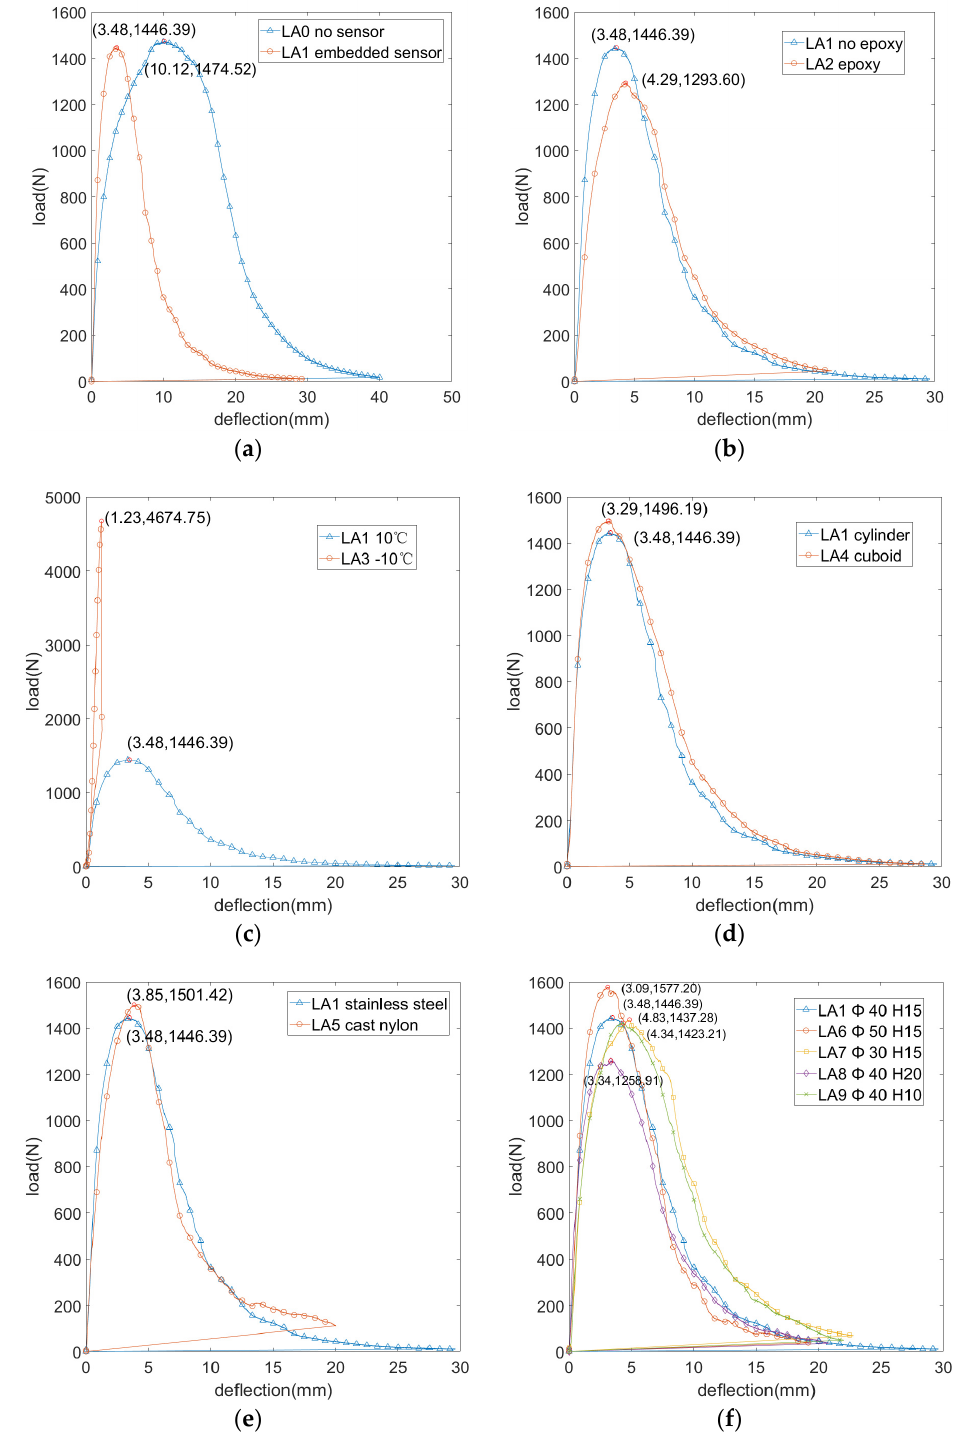
Figure 6. The load–midspan deflection curve under various test conditions. ( a ) Influence of embedded sensor; ( b ) influence of epoxy coating; ( c ) influence of temperature; ( d ) influence of sensor packaging shape; ( e ) influence of packaging material; ( f ) influence of sensor packaging size. The values of the evaluation indices were calculated according to Equations (1) through (5), with testing condition LA1 set as the control group marked with yellow col- umns. The results are shown in Figure 7.